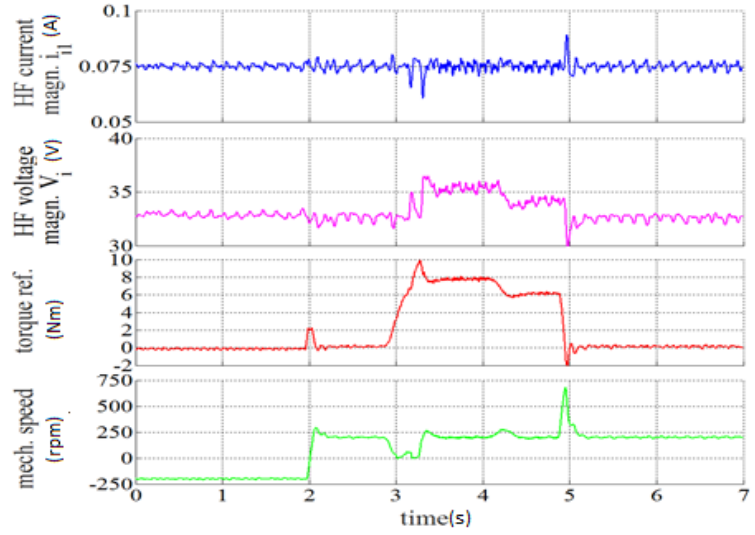
Figure 16. Motor #1: Sensorless speed control (MTPA), gain adaptation and 𝑖 𝑖1 regulation: – 200 to +200 rpm, no-load to 6 Nm to no-load.